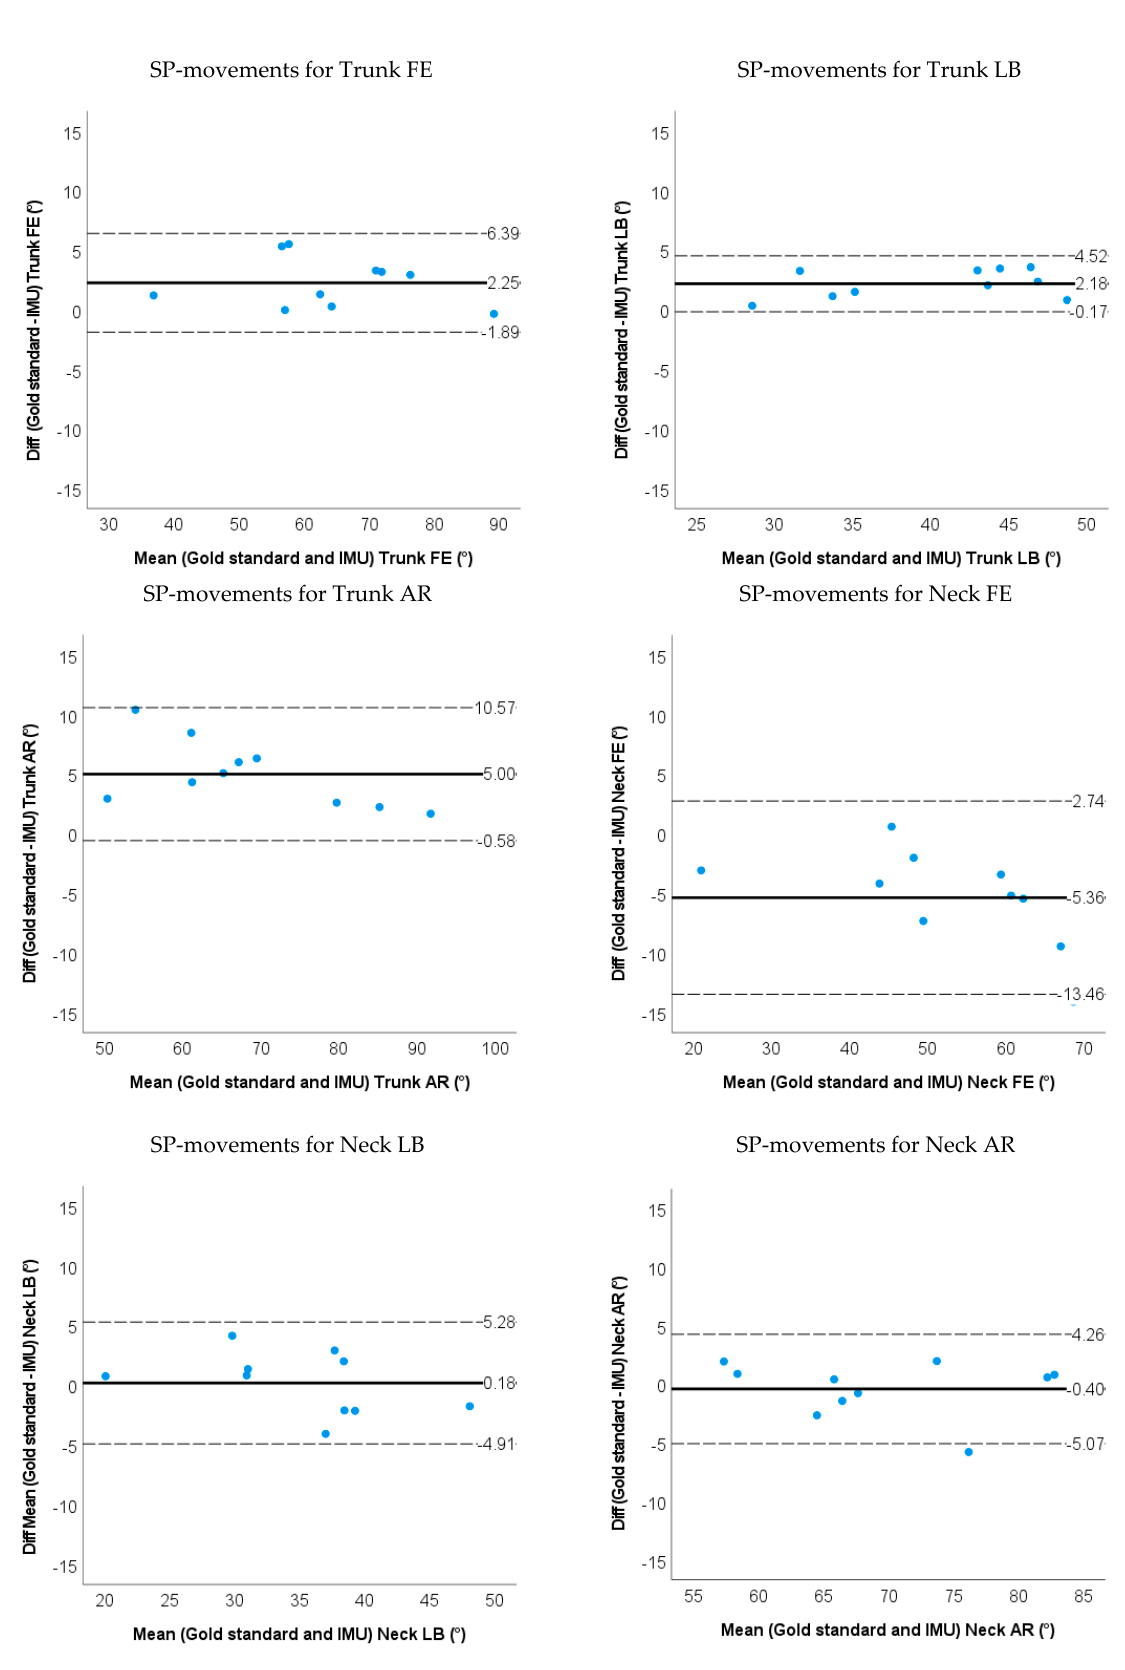
Figure 7. Bland − Altman plots for ROM of the trunk and neck angle obtained by the gold standard and IMU method for SP-movements. The solid line represents the mean difference, and the dashed line represents the 95% limits of agreement.